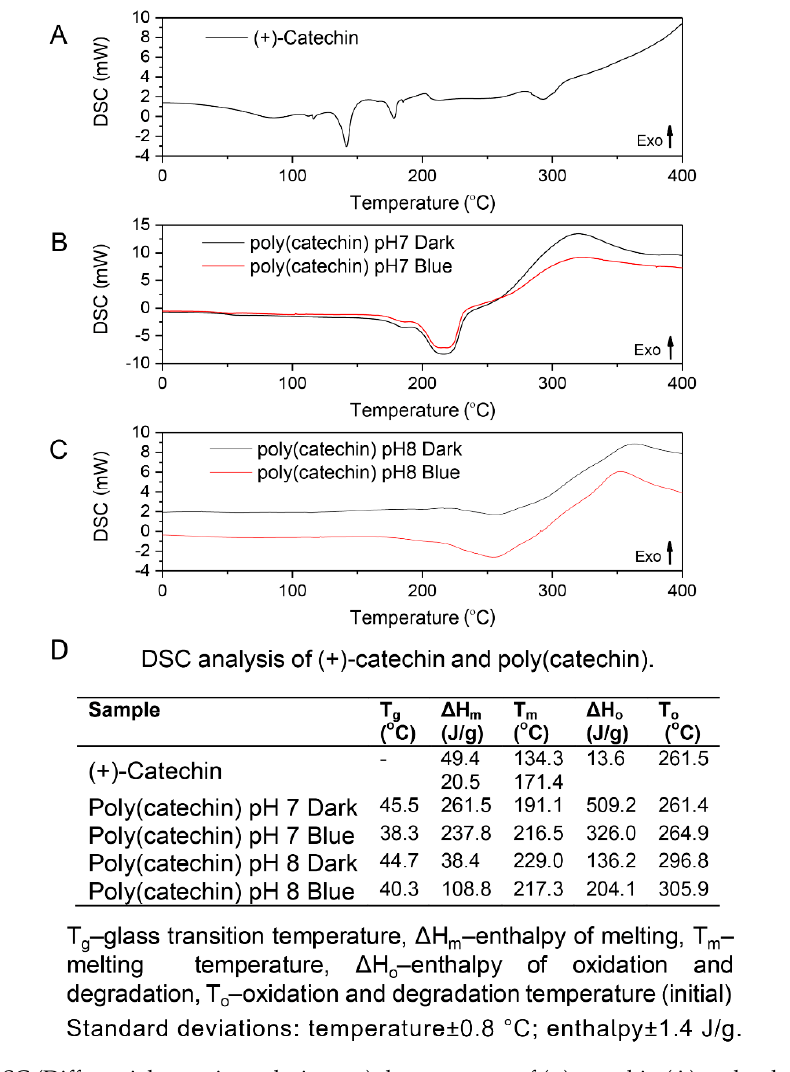
Figure 5. DSC (Di ff erential scanning calorimetry) thermograms of ( + )-catechin ( A ) and poly (catechin) Figure 5. DSC (Differential scanning calorimetry) thermograms of (+)-catechin ( A ) and poly (catechin) ( B , C ) samples. DSC analysis of ( + )-catechin and poly (catechin) ( D ( B,C ) samples. DSC analysis of (+)-catechin and poly (catechin) ( D ).